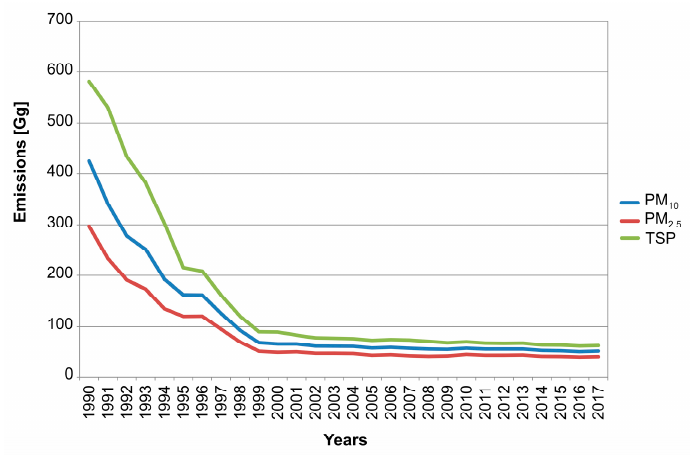
Figure 7. Overall emissions of TSP, PM 10 and PM 2.5 in the CR, according to EMEP data [97].